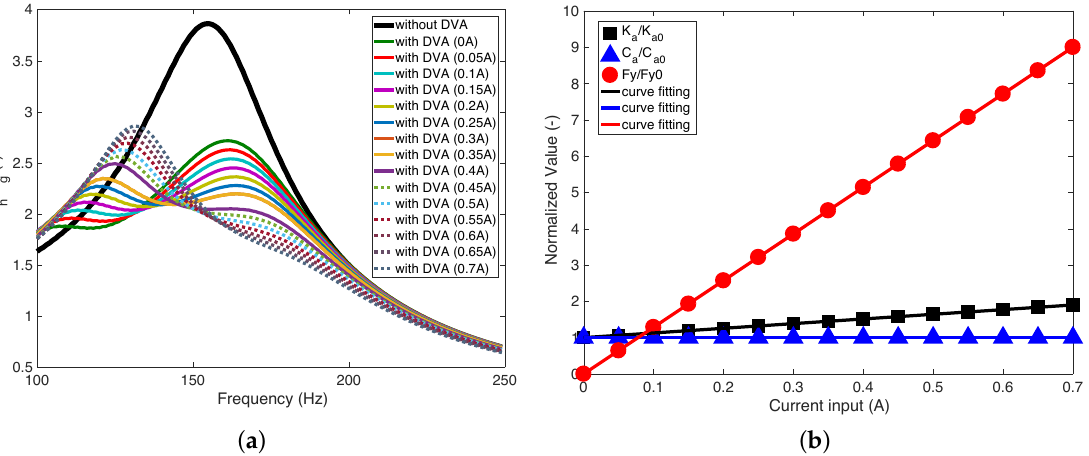
Figure 12. Simulated vibration isolation performance and identified system parameters of the MRE- DVA using the equivalent mechanical model: ( a ) simulated vibration isolation performance and ( b ) identified system parameters. Table 2. The identified system parameters for the MRE-DVA. Variables Values Mass of the target system, M h 1027 g Stiffness of the target system, K h 1005 kN/m Viscous damping of the target system, C h 274.3 N ·